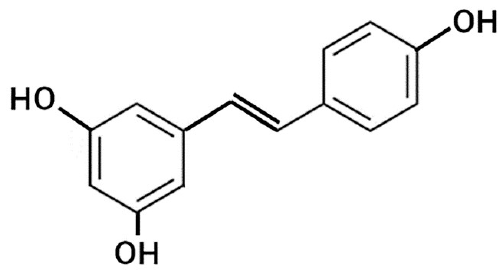
Figure 5. General structure of Figure 5. General s tructure of resveratrol.